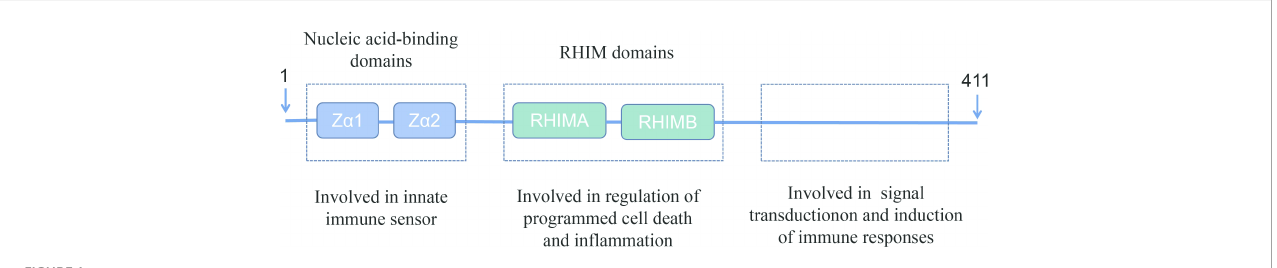
FIGURE 1 Schematic representation of full-length ZBP1. ZBP1 encodes two N-terminal Z-DNA-binding domains, which are reported to bind to Z-DNA, B-DNA, and RNA. ZBP1 also has two receptor-interacting protein homotypic interaction motif (RHIM) domains in the central part that facilitate the interaction with other RHIM domain-containing proteins. These RHIM domains are important in mediating ZBP1-dependent cell death and in fl ammatory responses (13,